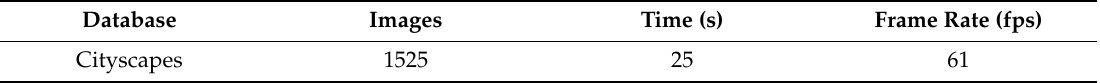
Table 2. Frame rate result for the proposed method with the Cityscapes database